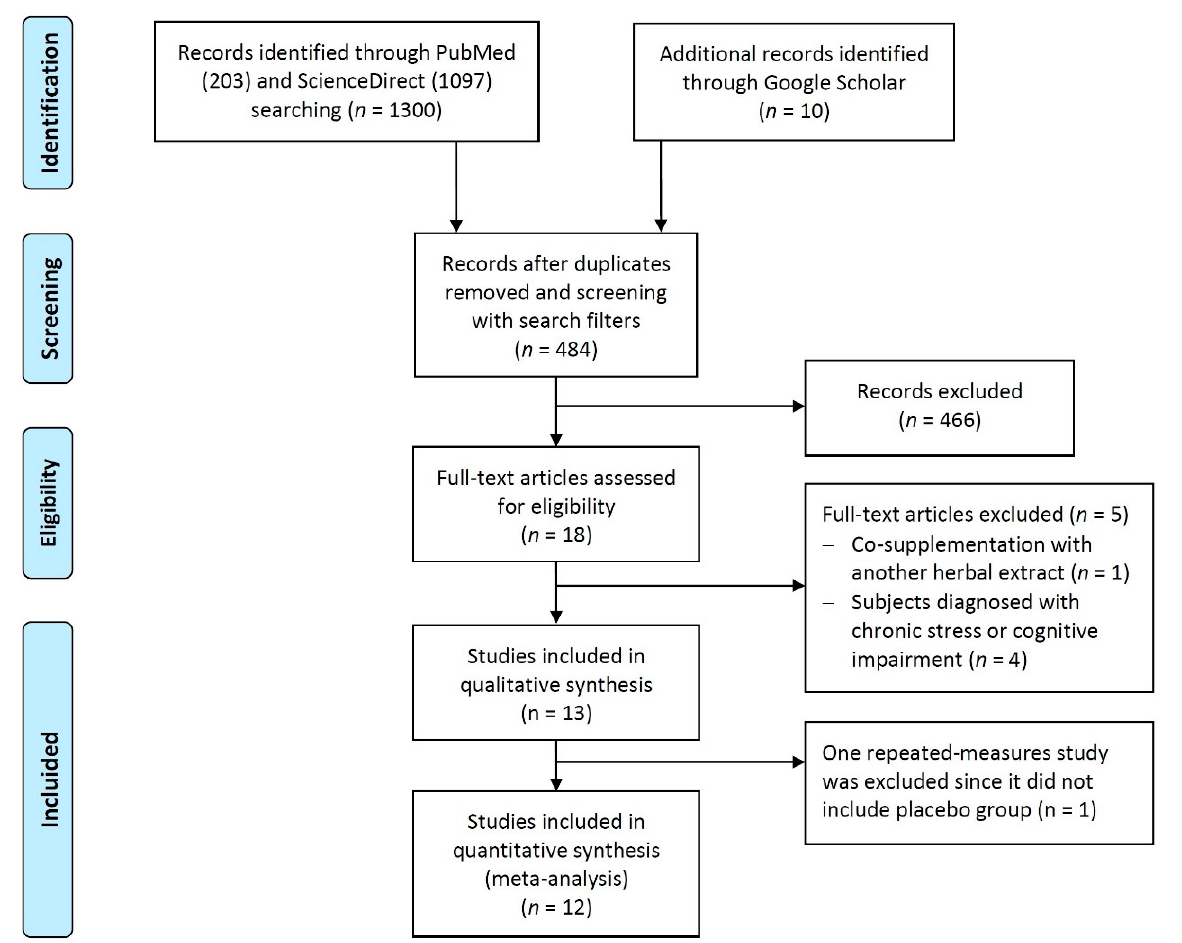
Figure 1. Preferred reporting items for systematic reviews and meta-analyses (PRISMA) flow diagram.